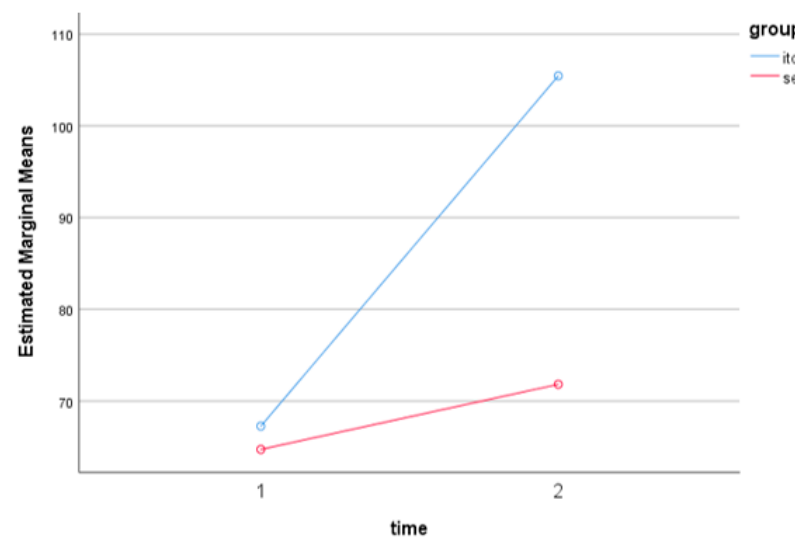
Figure 2. Estimated marginal means of Native Reliance